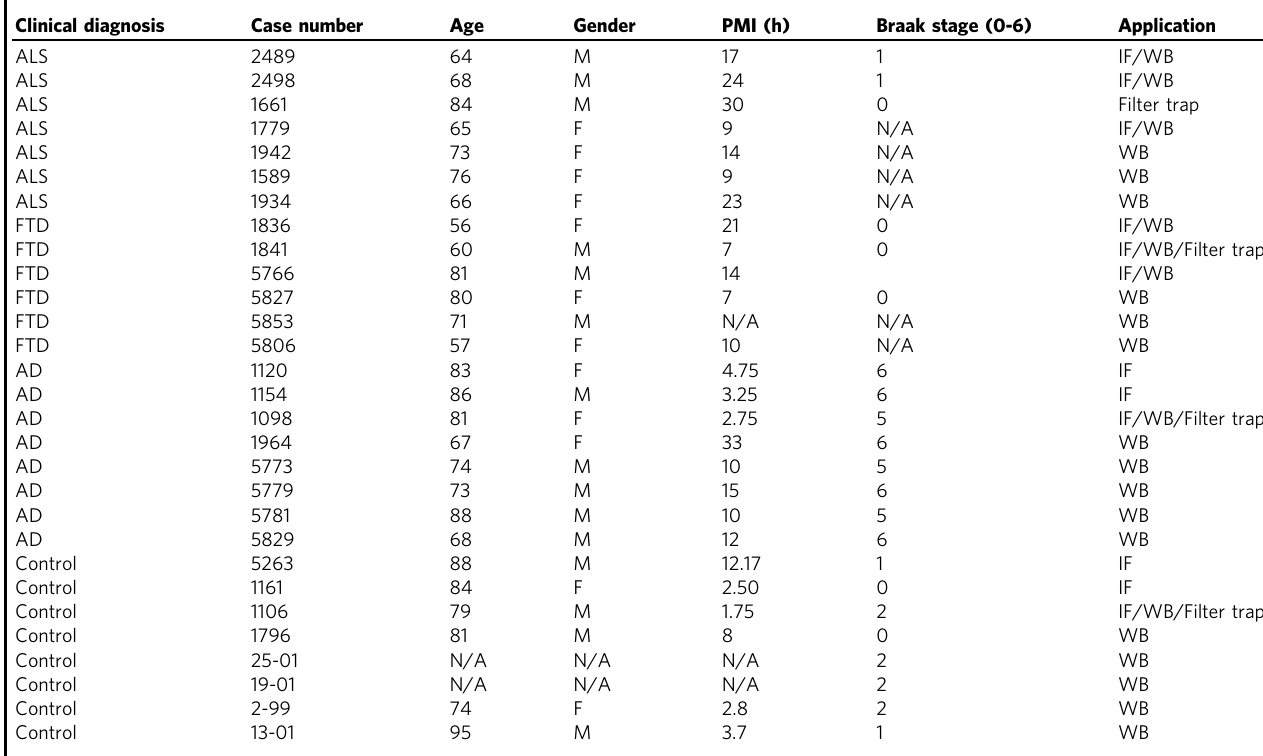
Table 1 Brain tissues analyzed in this study from diseased and age-matched control subjects. Clinical